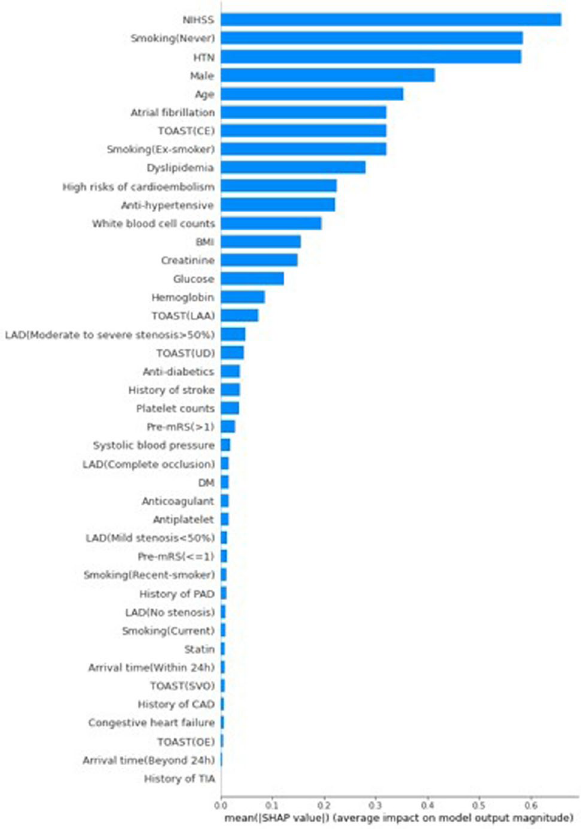
Figure 3. Feature importance matrix plots. In the bar plot, the SHAP value implies the degree of contribution of a specific feature. The higher the SHAP value is, the larger the model contribution of a specific